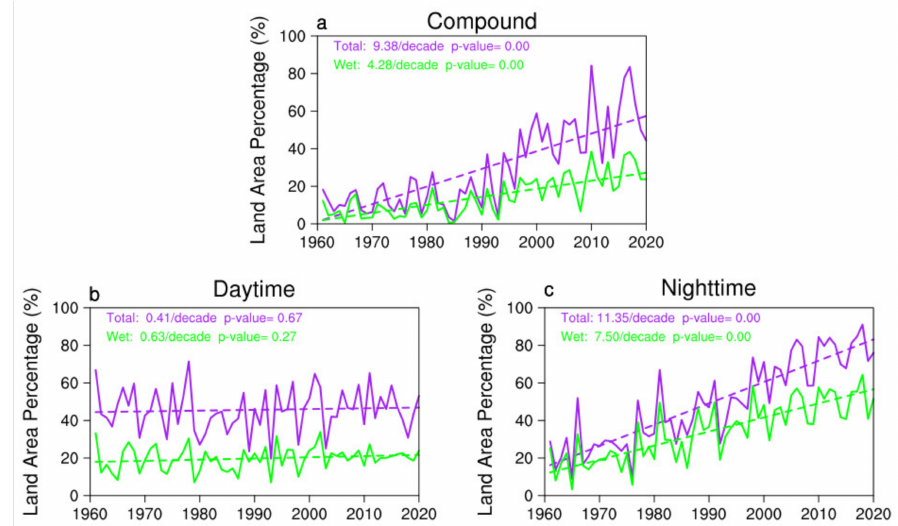
Figure 4. Temporal changes in percentage of land areas experiencing wet ( a ) compound, ( b ) daytime and ( c ) nighttime HWs from 1961 to 2020. Purple and green lines represent all HWs without restricting the wetness level and wet HWs with Rhu exceeding 60%, respectively.